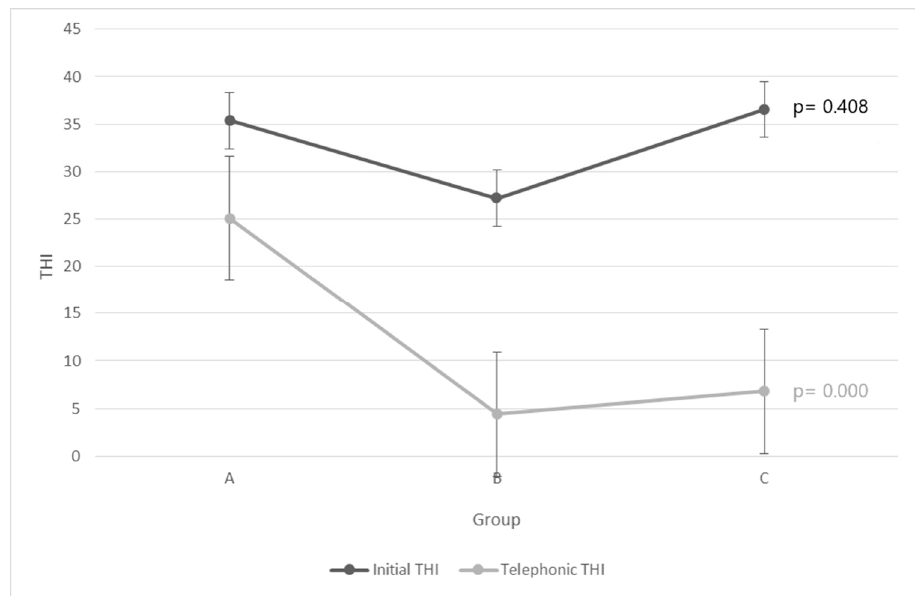
Figure 2. Initial and telephonic THI values in patients divided according to their answers to question no. 3 of the questionnaire (Table 1) with their relative error bars and significance.